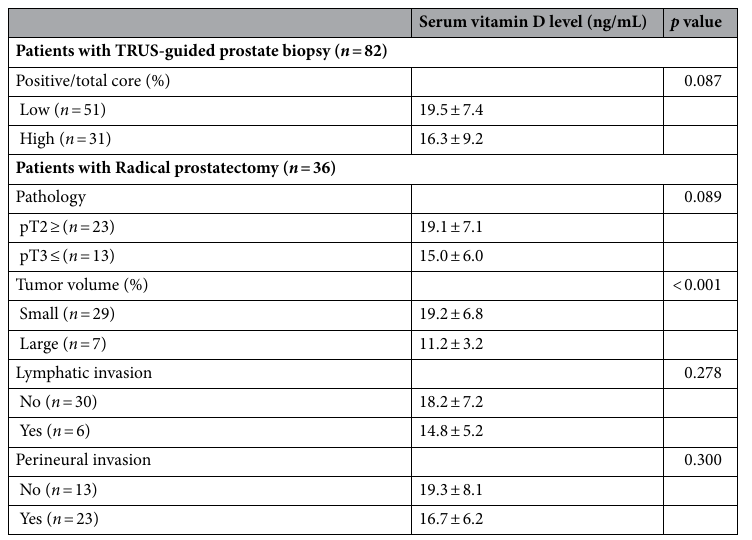
Table 2. Serum vitamin D level according to pathohistological results. pT2 pathologic T2 stage, pT3 pathologic T3 stage.